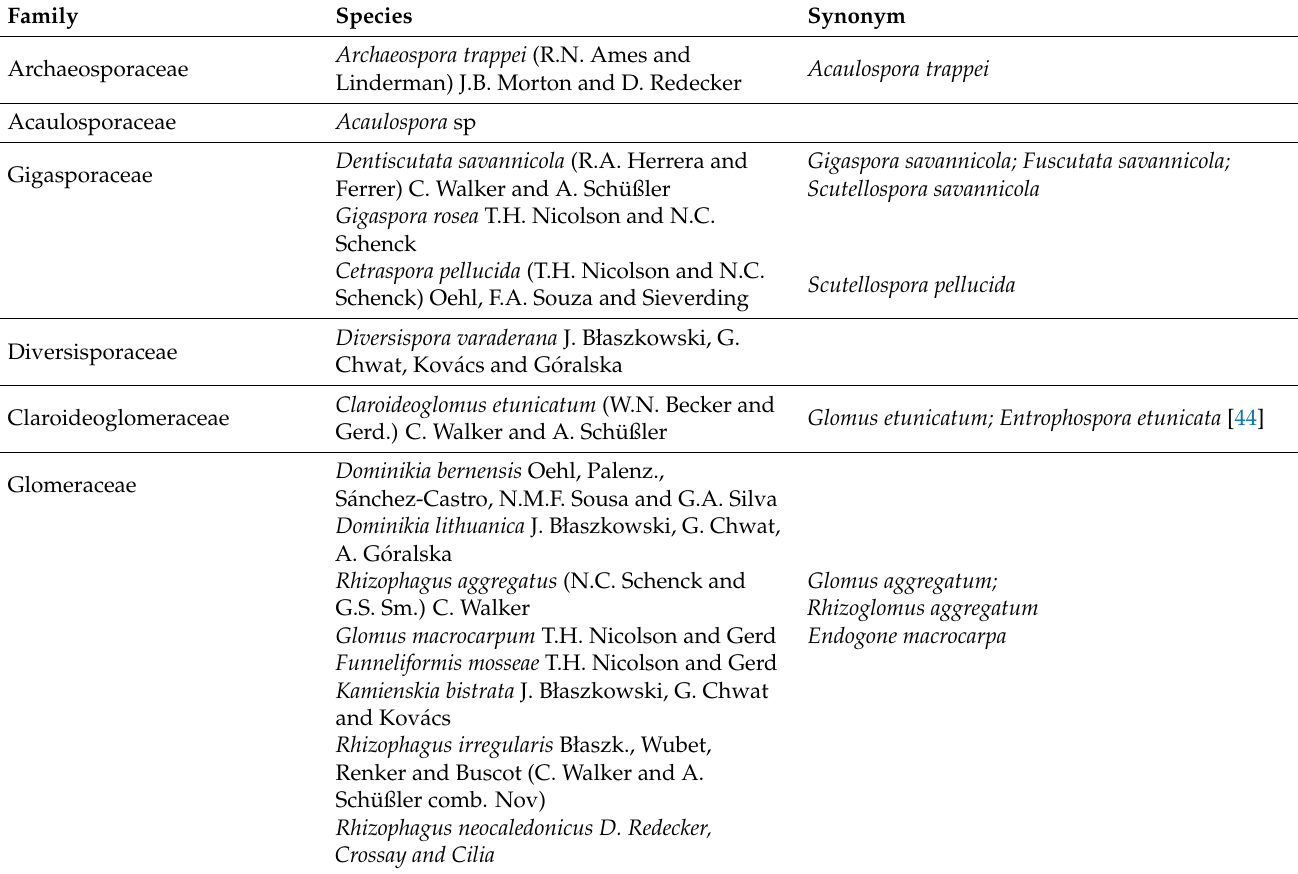
Table 1. List of arbuscular mycorrhizal fungi (AMF) species contained in the inoculum identified by SSU rRNA sequence